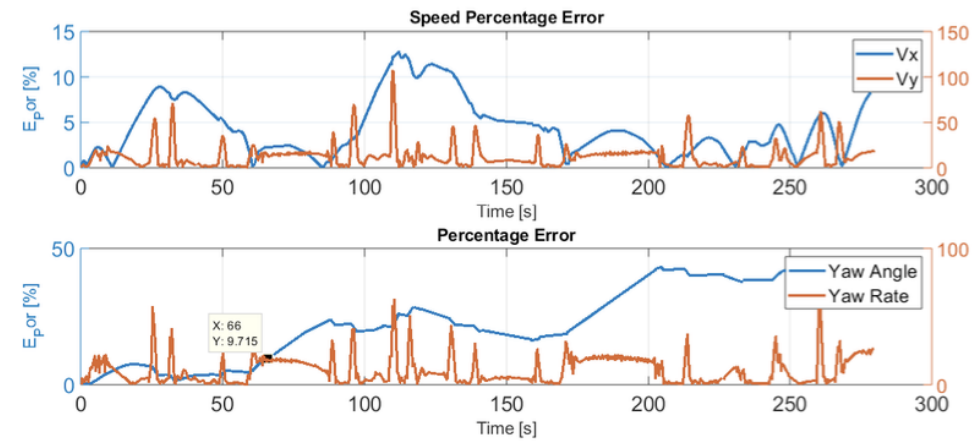
Figure 22. Dynamic speed profile results after sensitivity test (error